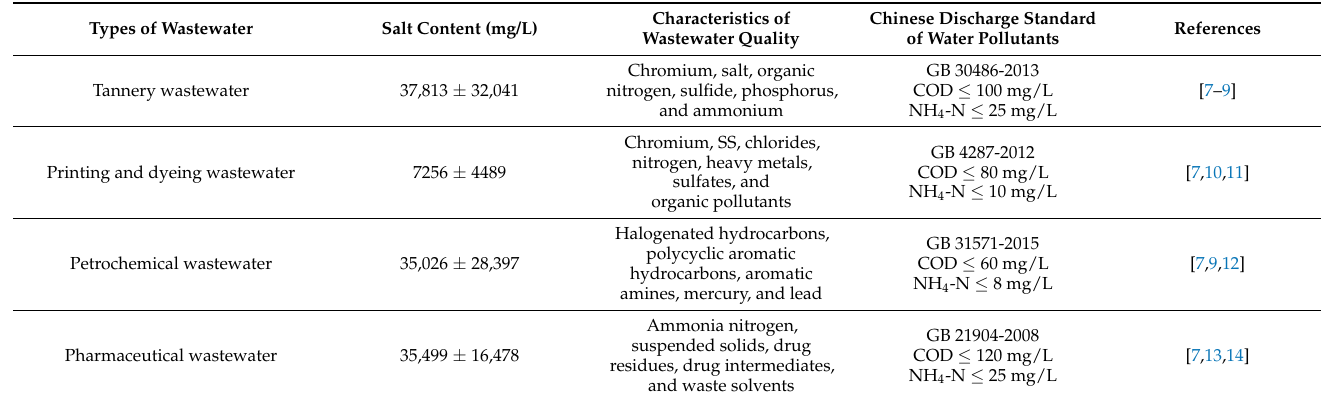
Table 1. Wastewater quality from different industrial